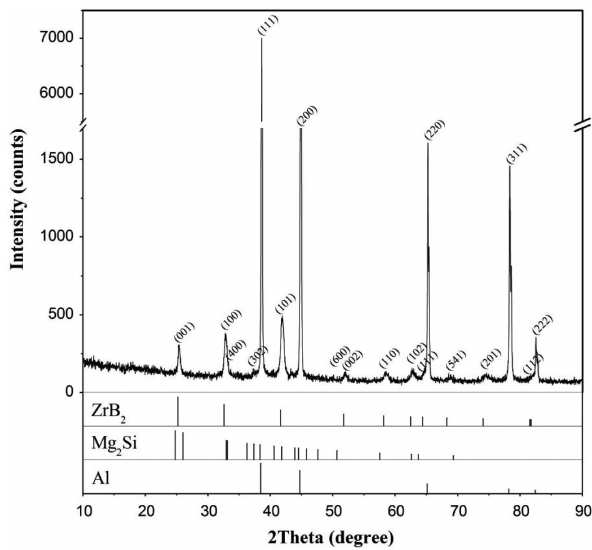
Figure 2: XRD pattern of as-prepared ZrB 2p /6061Al composites.